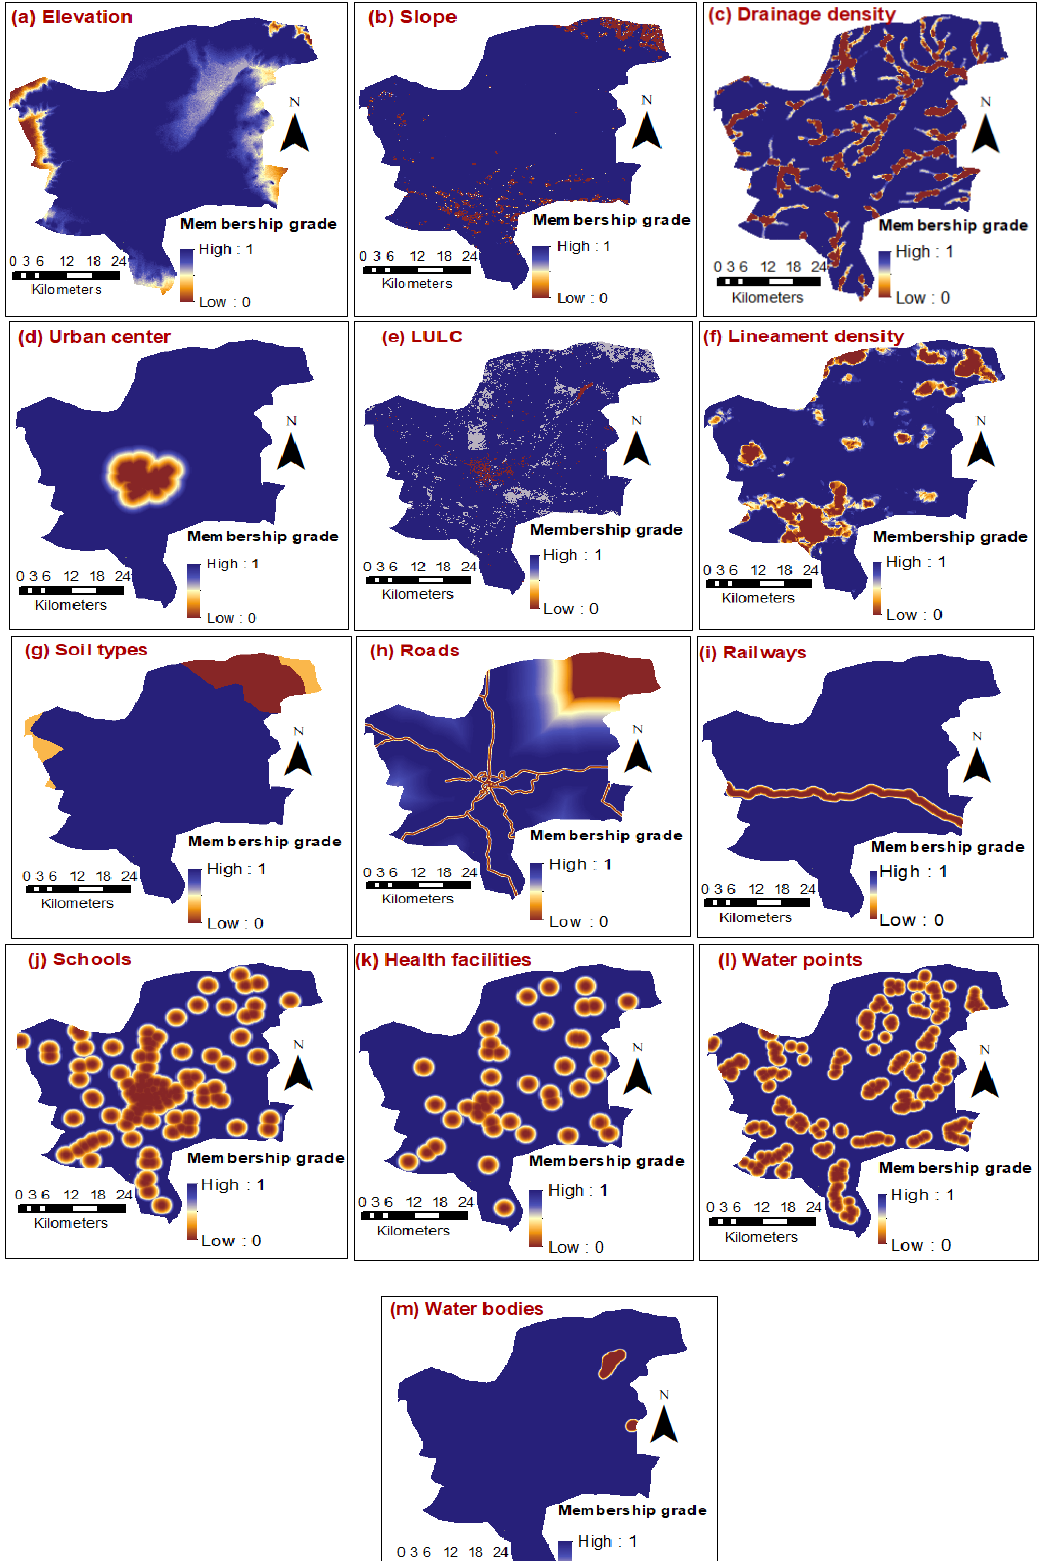
Figure 4. Membership grade of decision criteria ( a – m ).